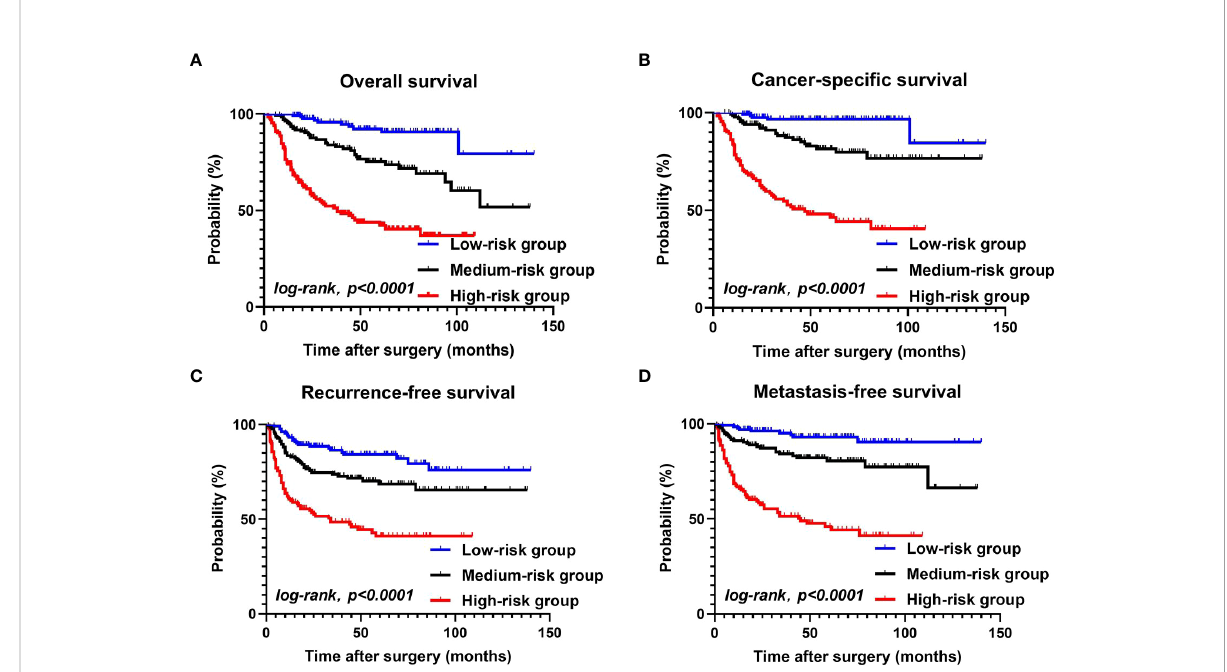
FIGURE 2 OS, CSS, RFS, MFS between the low-risk group, the medium-risk group, and the high-risk group (A – D)